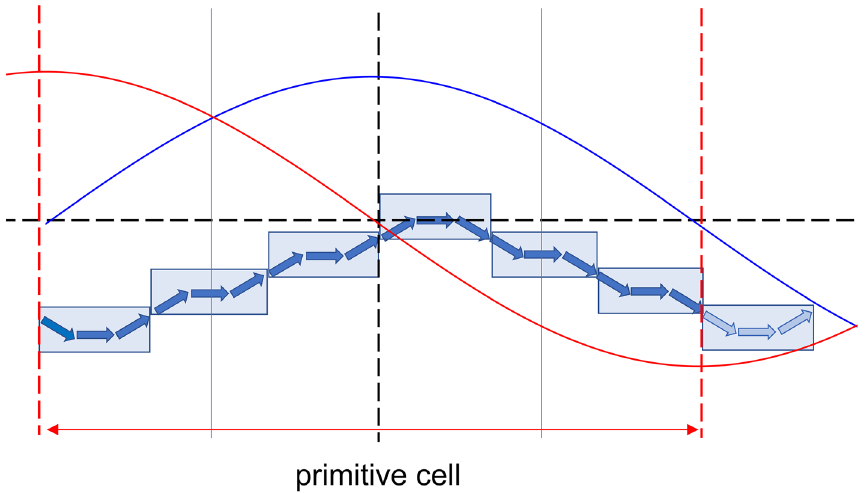
Figure 13. Sketch of the correspondence between magnetization undulation and spin oscillation wavelength at zone boundary (k = π/a) for the system made of 6-stripes. Black dashed lines set the reference system, the blue and red lines represent the two diffracted waves at zone boundary, having a phase difference of π/2. Apparently, even when M is not uniform, the two solutions experience point by point exactly the same magnetization flux lines (illustrated by the blue arrows), resulting indistinguishable and hence in principle degenerate in frequency. This happens any time that λ/4 is an integer of the stripe width